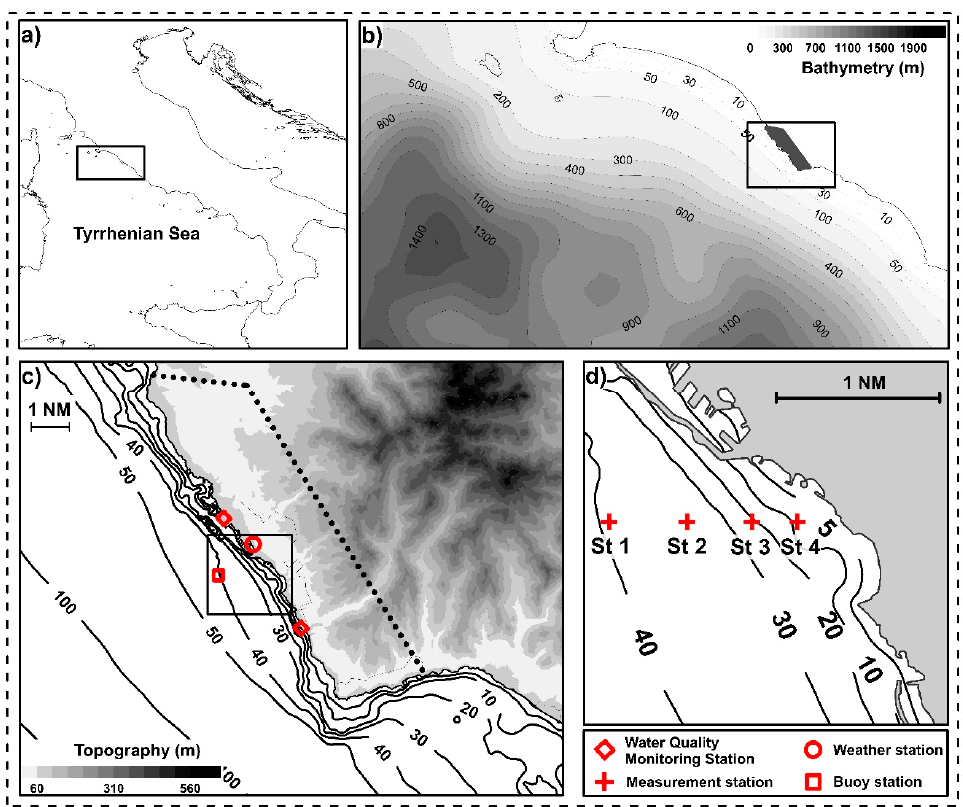
Figure 1. ( a ) Map of the Tyrrhenian Sea with a part of the study area (in white). ( b ) Bathymetric map of the Northern Tyrrhenian east coast; the black polygon is the study area. ( c ) Topographic map of the coastal zone of Civitavecchia and the observatory system. ( d ) The location of the measurement stations.